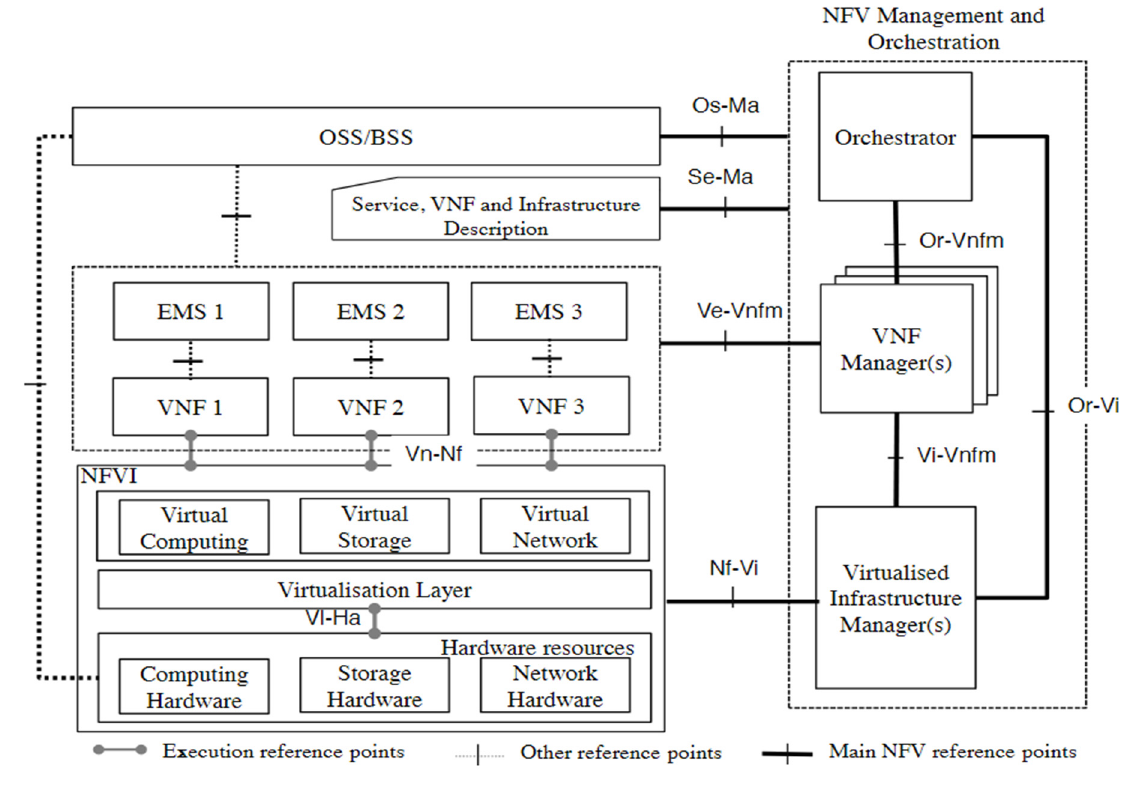
Figure 1. High-level NFV framework [3].